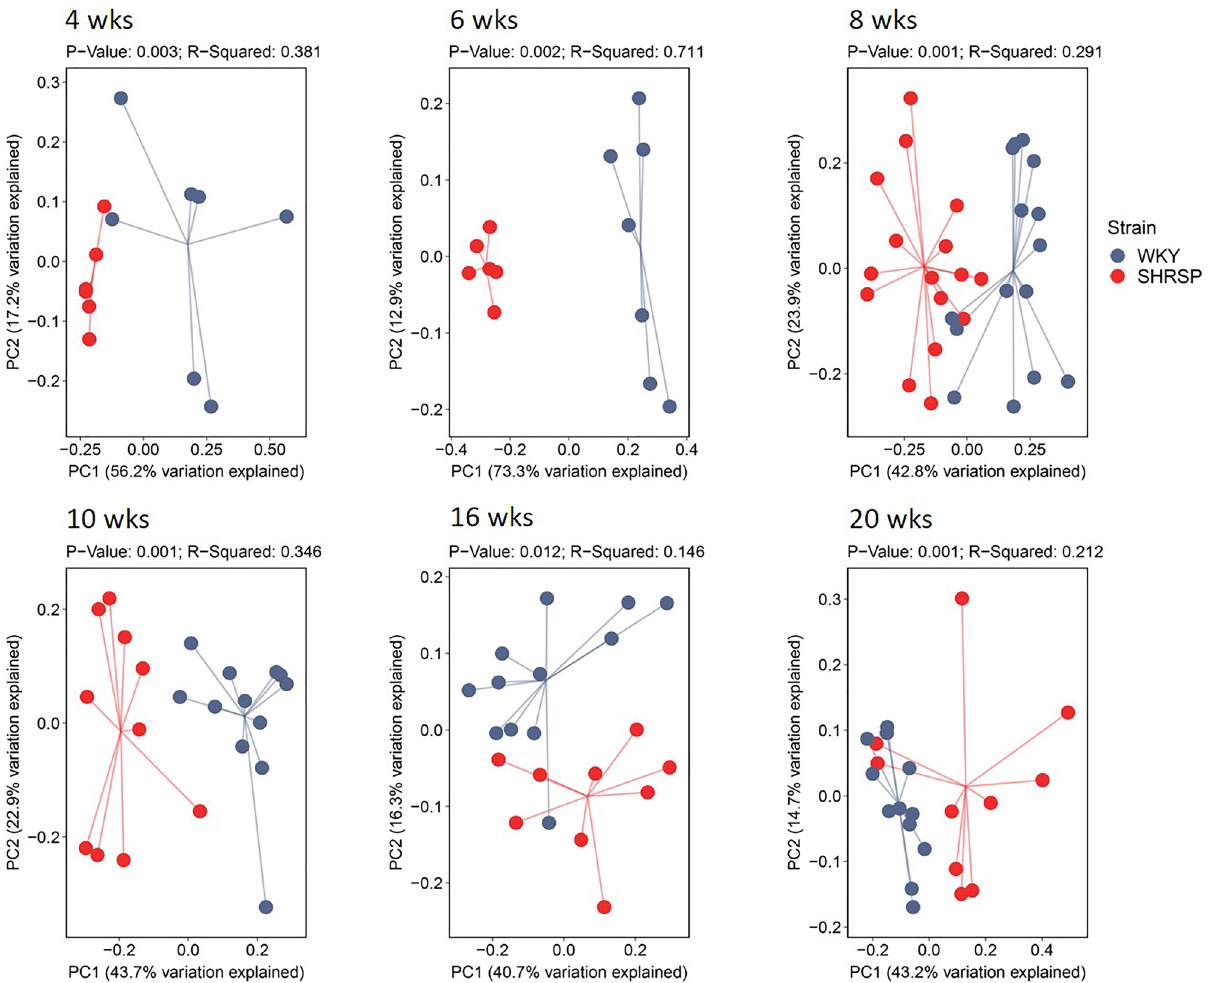
Figure 2. PCoAs of weighted UniFrac, measure of β diversities, comparing SHRSPs and WKYs at 4, 6, 8, 10, 16, and 20 weeks of age. The p-values, as determined using permutational multivariate analysis of variance (PERMANOVA), comparing SHRSPs and WKYs at each age group are presented at the top of each plot. n =